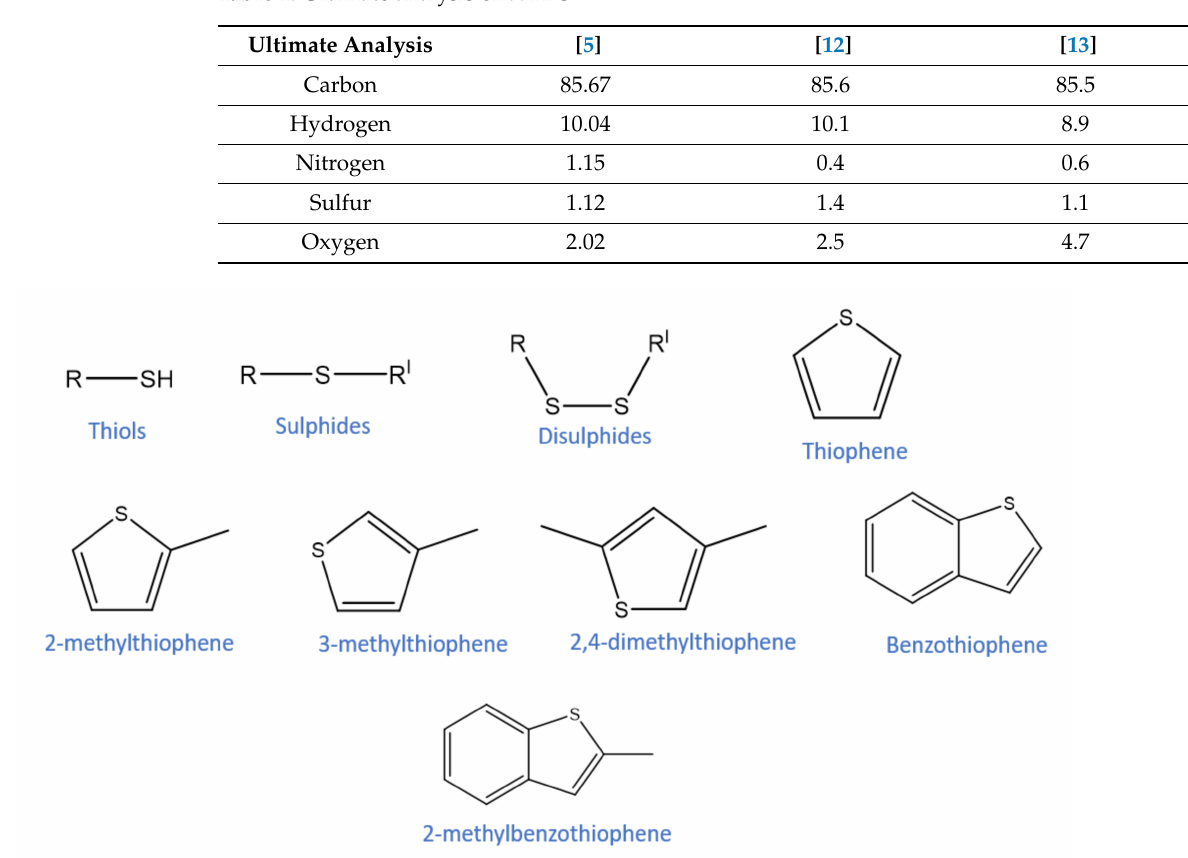
Figure 1. Various sulfur